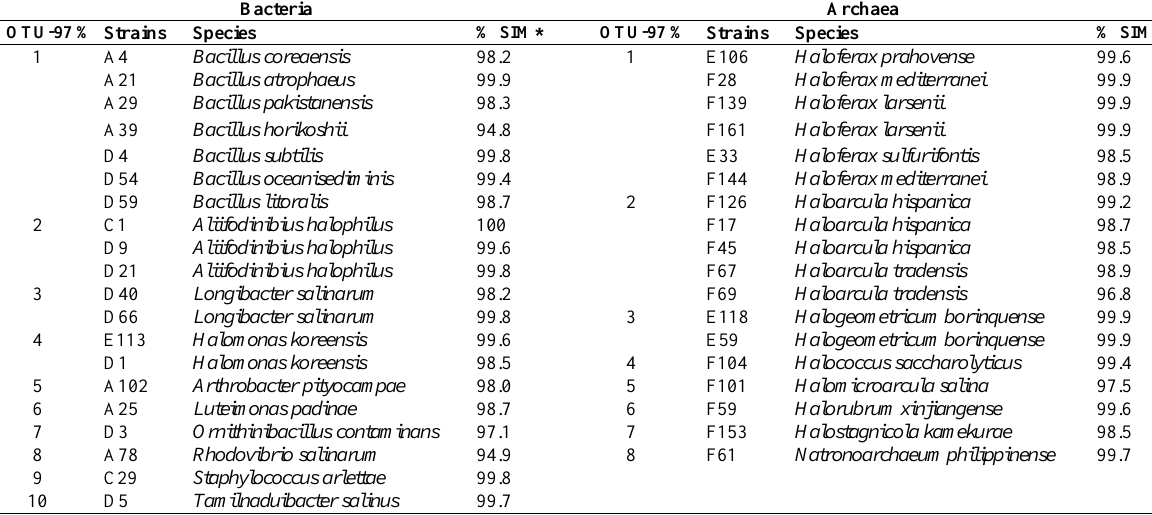
Table 2. Comparison of isolates sequences obtained from Tis saltern pond with those available in Ezbiocloud (Chun et al.